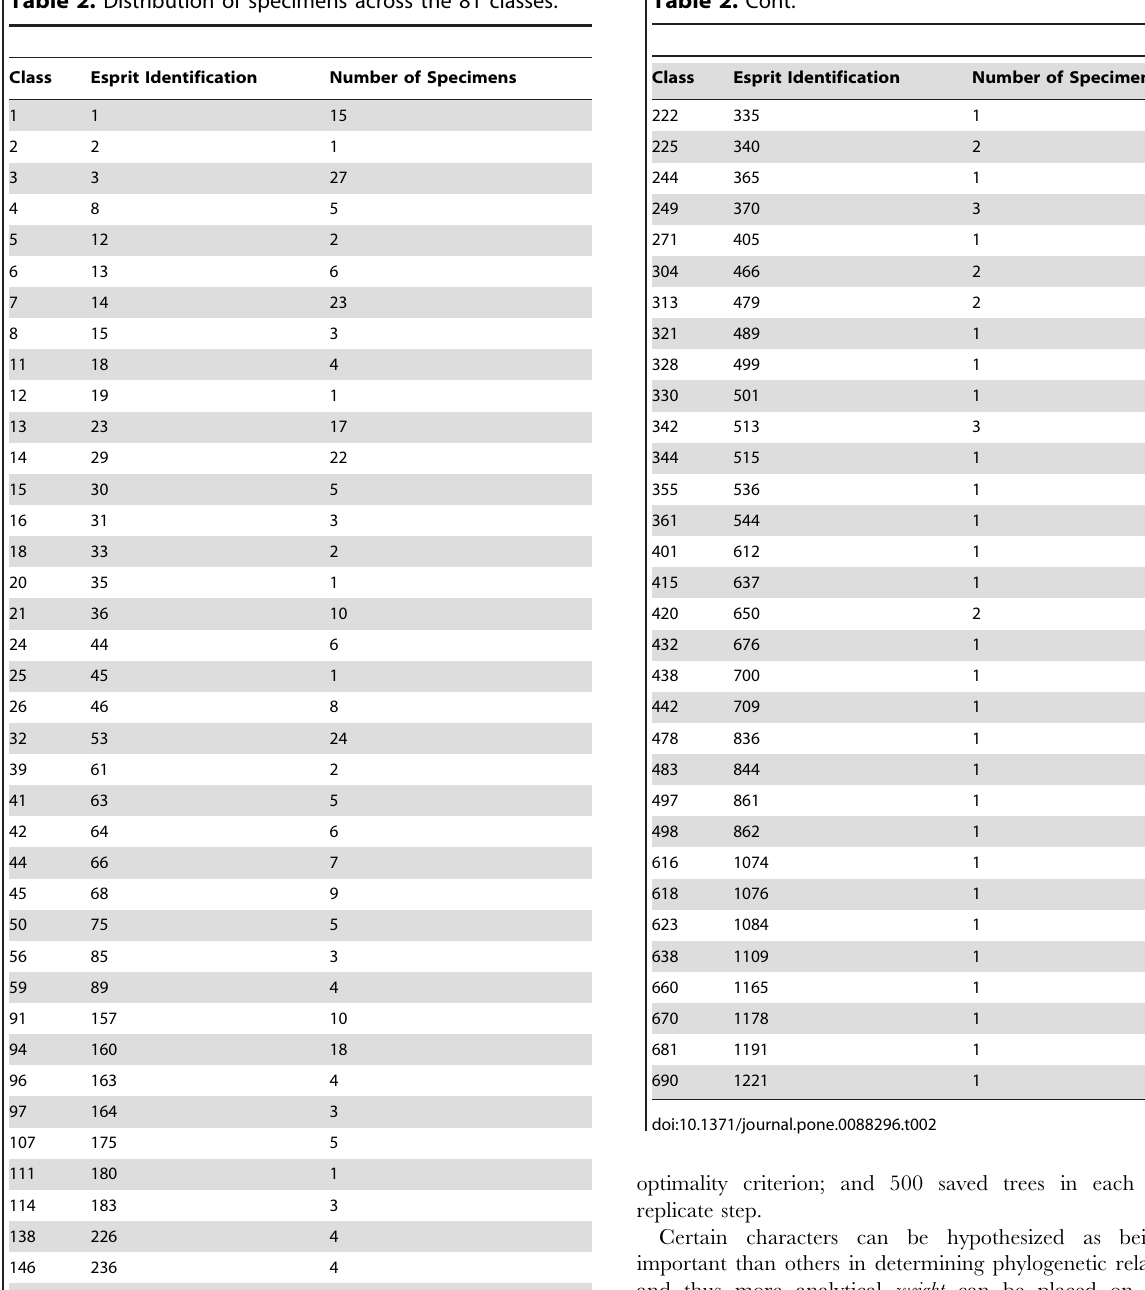
Table 2. Distribution of specimens across the 81 classes. Table 2.